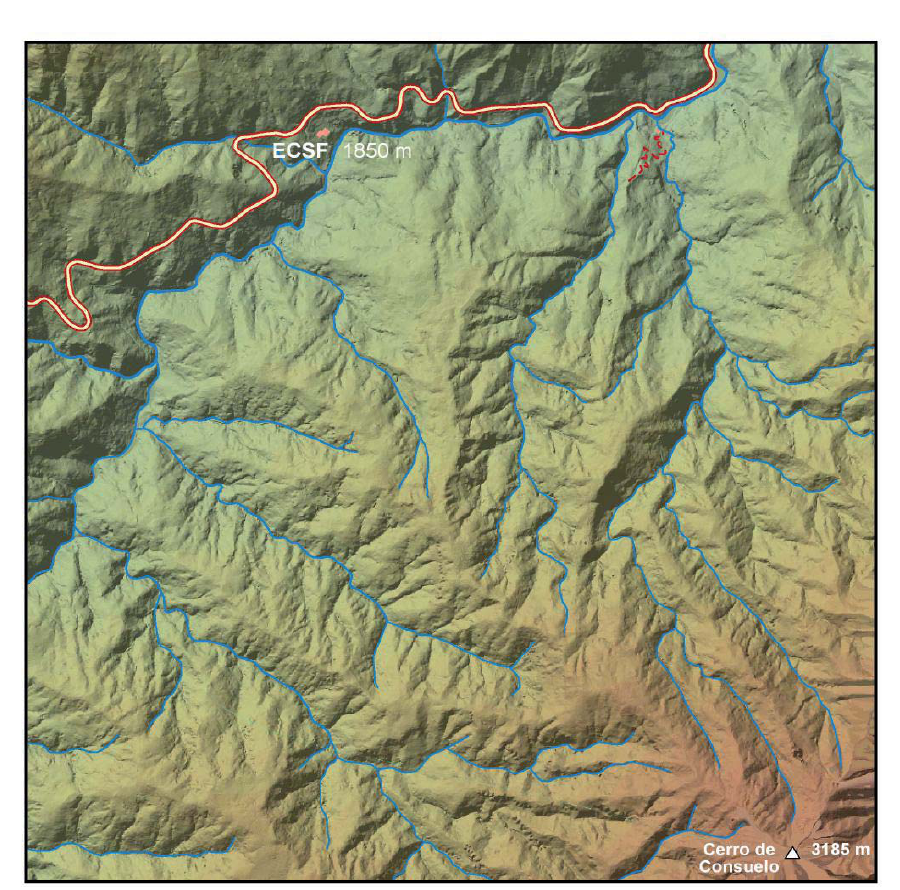
Figure 13: Orography of the RBSF-terrain between the Estacion Científica next to the Rio San Francisco (ECSF) and the mountain top Cerro de